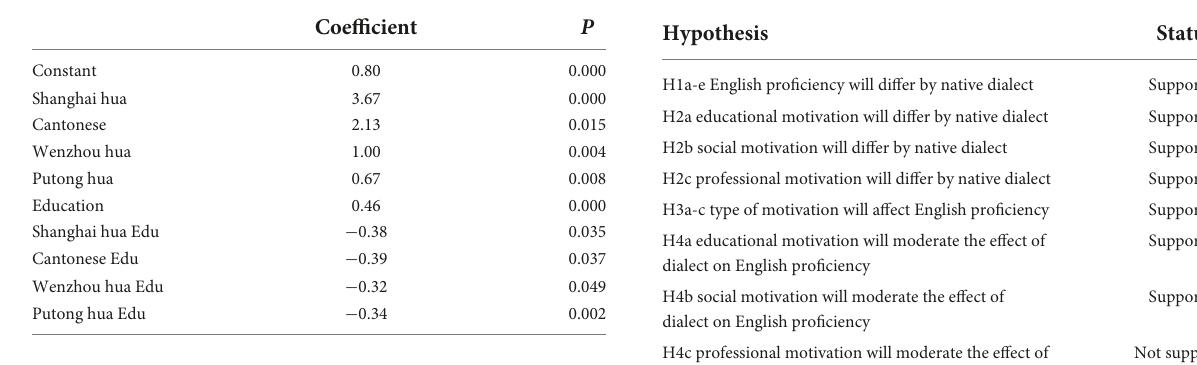
TABLE 11 Hypothesis testing